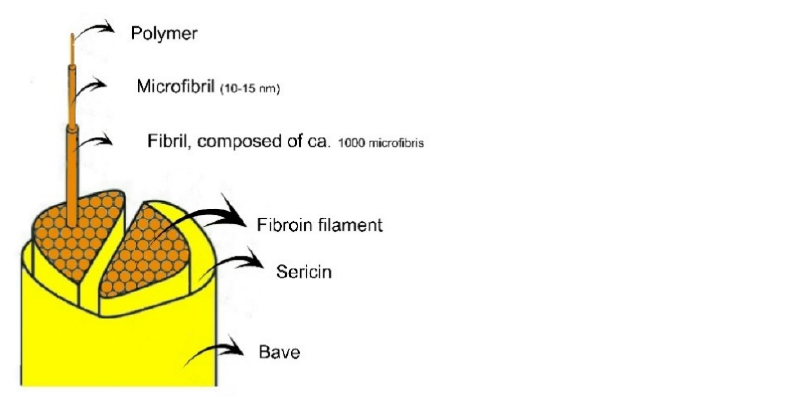
Figure 1. Schematic representation of the structural components of a raw silk fiber from the B. mori silkworm.